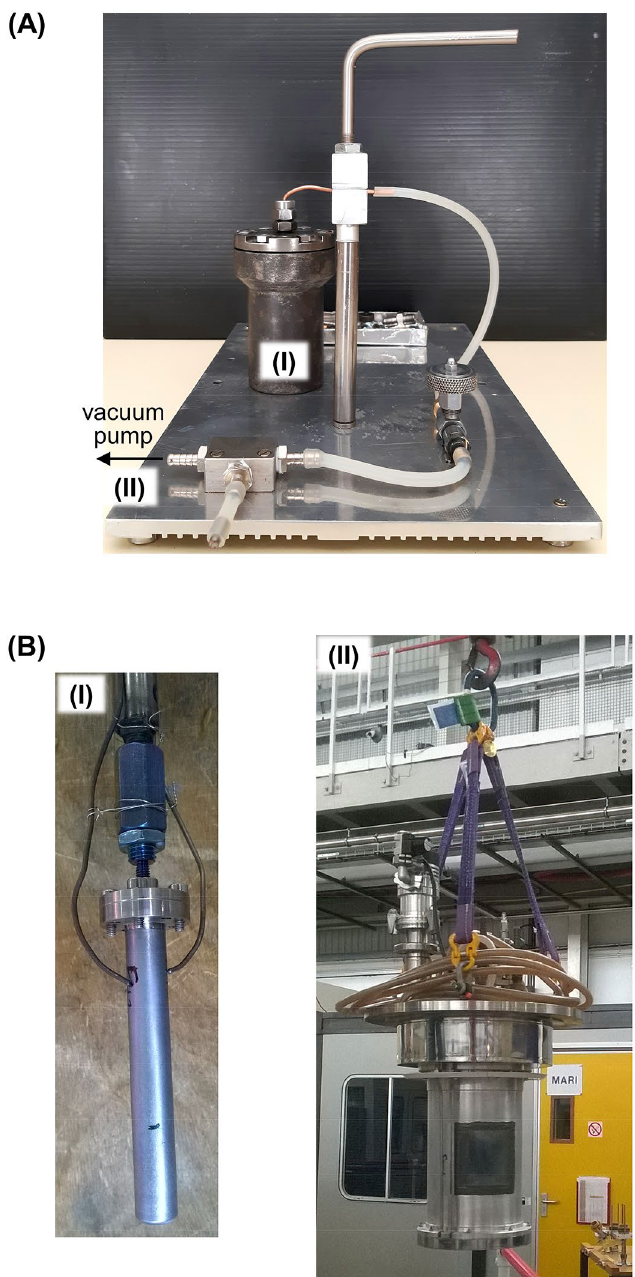
Figure 1. Experimental setups for the burning process of human bone samples under controlled anaerobic conditions: ( A ) An sealed —each bone fragment was placed inside a home-made steel airtight chamber (I) which was vacuum-pumped (II) and then inserted into an electric muffle furnace for heating at defined temperatures (at the University of Coimbra, Portugal); ( B ) An unsealed —each powdered bone sample was placed into a vanadium container (I) with a perforated lid (allowing volatiles venting), that was inserted into the instrument furnace (II), under vacuum, and heated at defined temperatures (GEM instrument, at the ISIS Facility, United